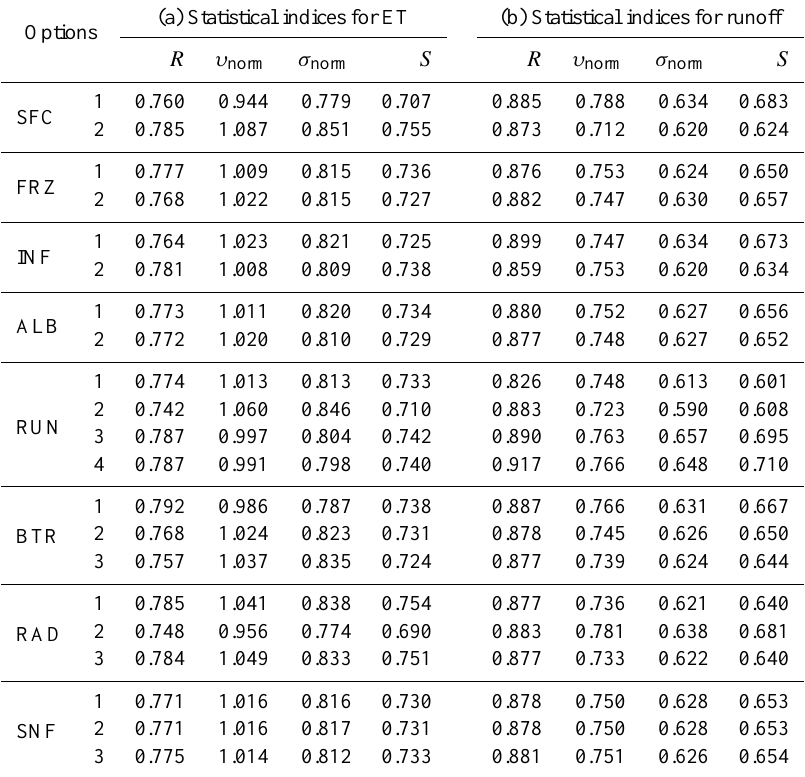
Table 2. Averaged statistical indices for (a) ET and (b) runoff to the observations ( R : correlation coefficient; υ norm : normalized mean; σ norm : normalized standard deviation; S : skill score). Each index indicates the averaged one for simulations of all scheme combinations with one fixed-scheme in a certain scheme category.